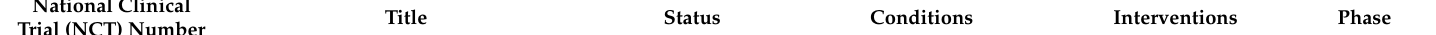
Table 8. Clinical trials investigating therapies targeting the MAPK pathway and immunotherapies in patients with colorectal cancer. National Clinical Trial (NCT)